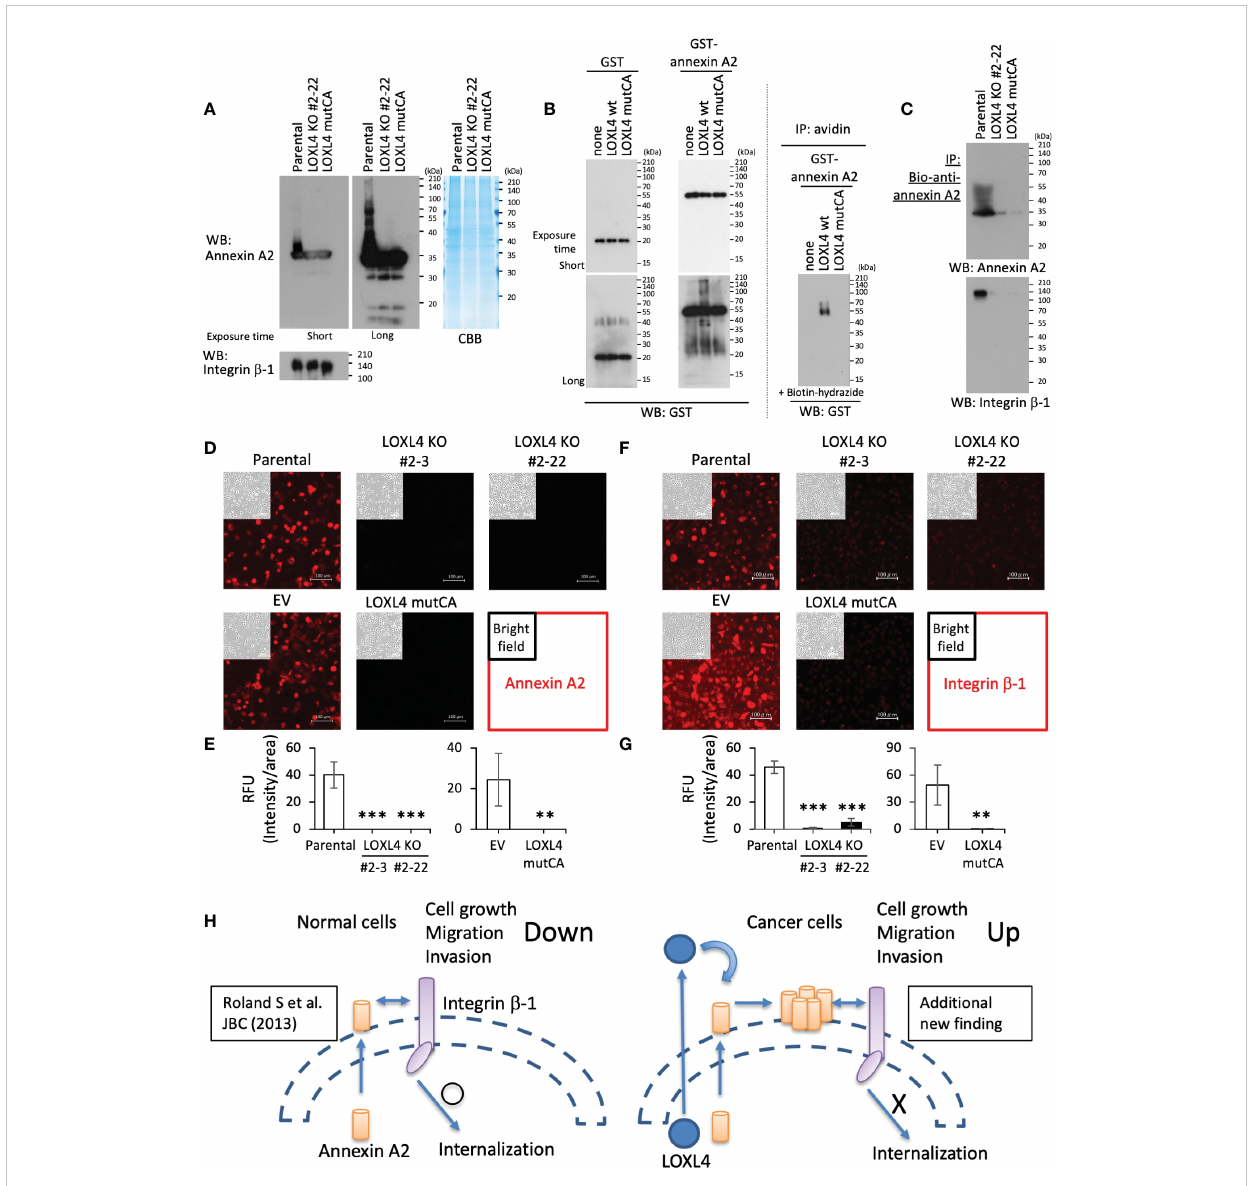
FIGURE 4 LOXL4-mediated regulation of the cell-surface locations and functions of annexin A2 and integrin b -1. (A) : The indicated cells were lysed and subjected to WB for the evaluation of their intrinsic levels and states of annexin A2 and integrin b -1. (B) : The pulled-down LOXL4 wt or mutCA was mixed with the prepared recombinant proteins (GST or GST-annexin A2) according to the indicated formula, and the mixed solutions were then incubated at 37°C for 24 hr ( left ). The reactants were then subjected to WB with the GST antibody. The same reactants were also